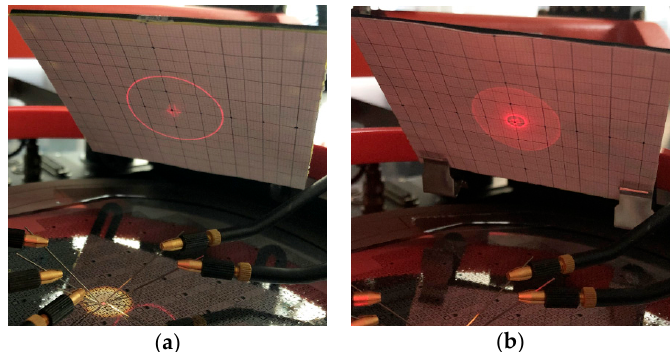
Figure 27. Scan pattern of Design 1 at 10 V: ( a ) spiral scan line without amplitude modulation; ( b ) spiral scan pattern by amplitude modulation.